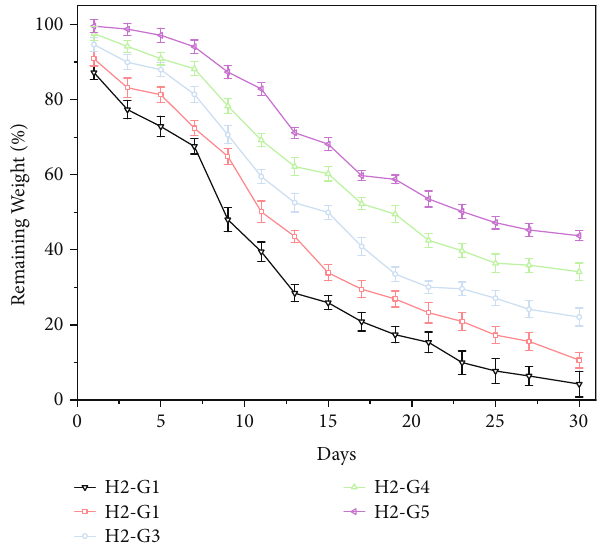
Figure 8: In vitro degradation of hydrogels H2-G1 to H2-G5 in SCF (pH7.4) at 37 ° C for 30